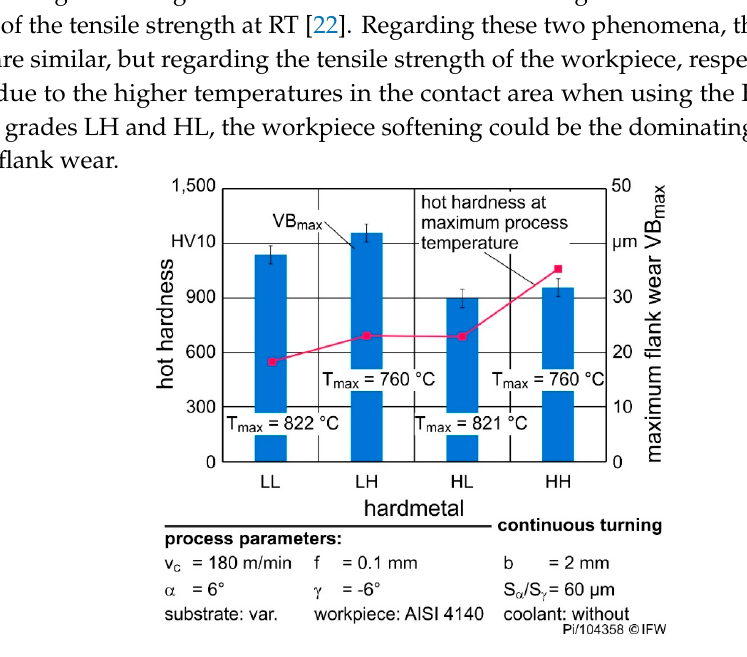
Figure 10. Maximum flank wear and effective hardness (hot hardness) of the used cemented carbides (continuous cutting, v c = 180 m/min, cutting edge rounding S α = S γ = 60 µm, rake face distance = 0.06 µm).